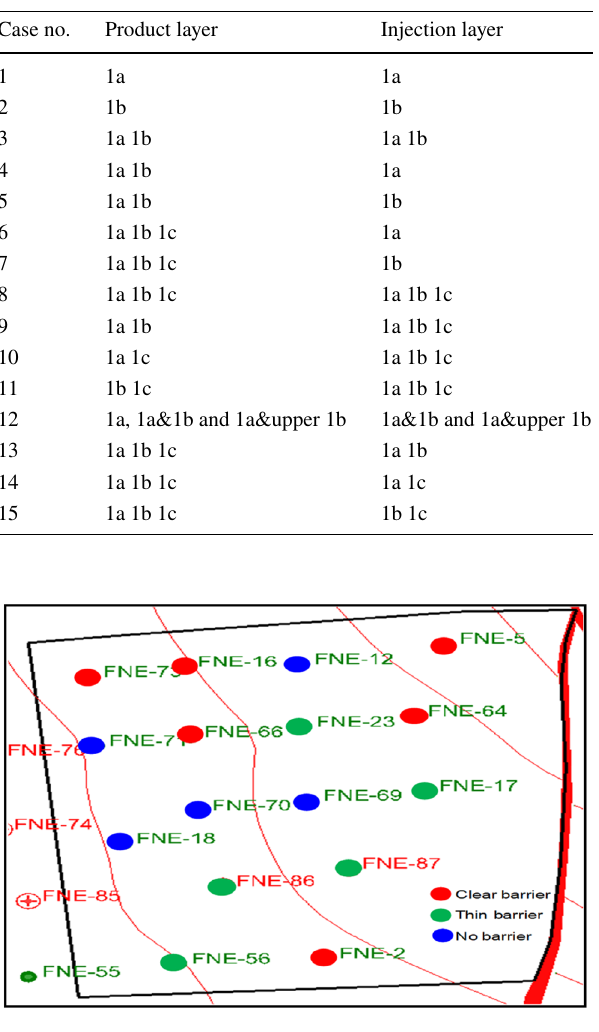
Fig. 9 Well type distribution